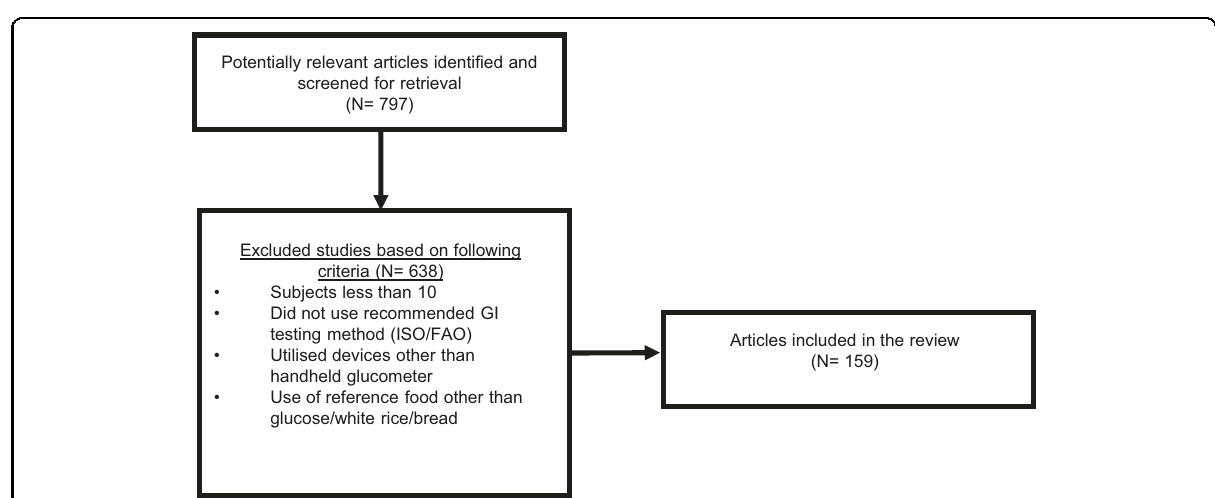
Fig. 1 Flowchart illustrating number of studies screened, excluded and included. N - number of studies, ISO - International Organisation for Standardisation, FAO - Food and Agriculture